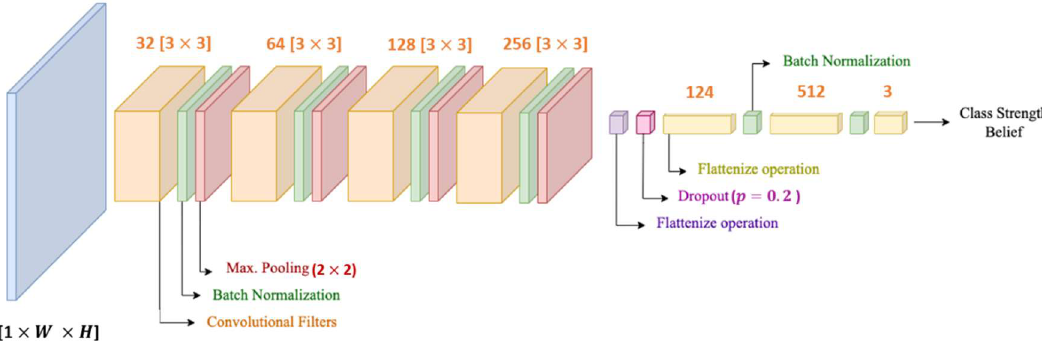
Figure 8. The Convolutional Neural Network proposed for the mini-crop classification